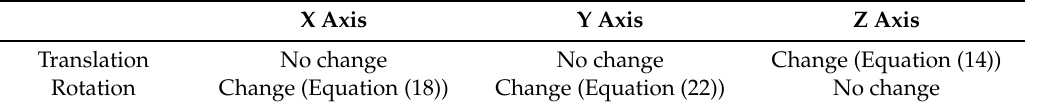
Table 2. Change of the pupil-corneal SR vector according to head